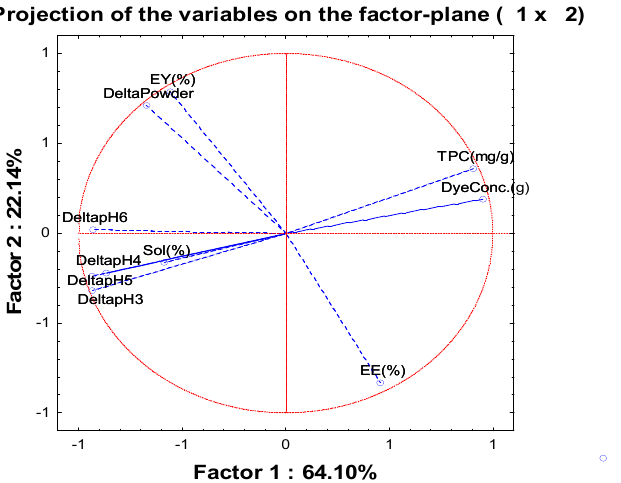
Figure 4. Principal component analysis with six active and four supplementary variables. Abbreviations: encapsulation efficiency (EE), encapsulation yield (EY), dye concentration (Dye Conc.), solubility (Sol), powder colour variation ( Δ powder), colour variation at pH 3, pH 4, pH 5 and pH 6 ( Δ E* pH 3, Δ E* pH 4, Δ E* pH 5 and Δ E* pH 6).